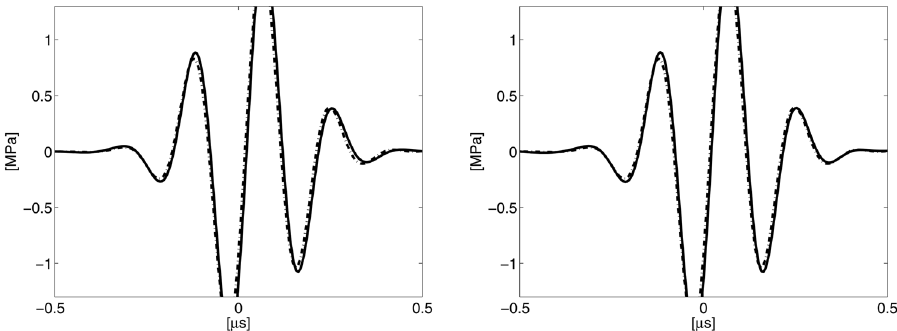
Figure 8. Cross-section comparing a numerical solution to the full wave equation (dash-dot line) to a numerical solution of the one-way models (solid line). Left: parabolic model. Right: pseudo-differential